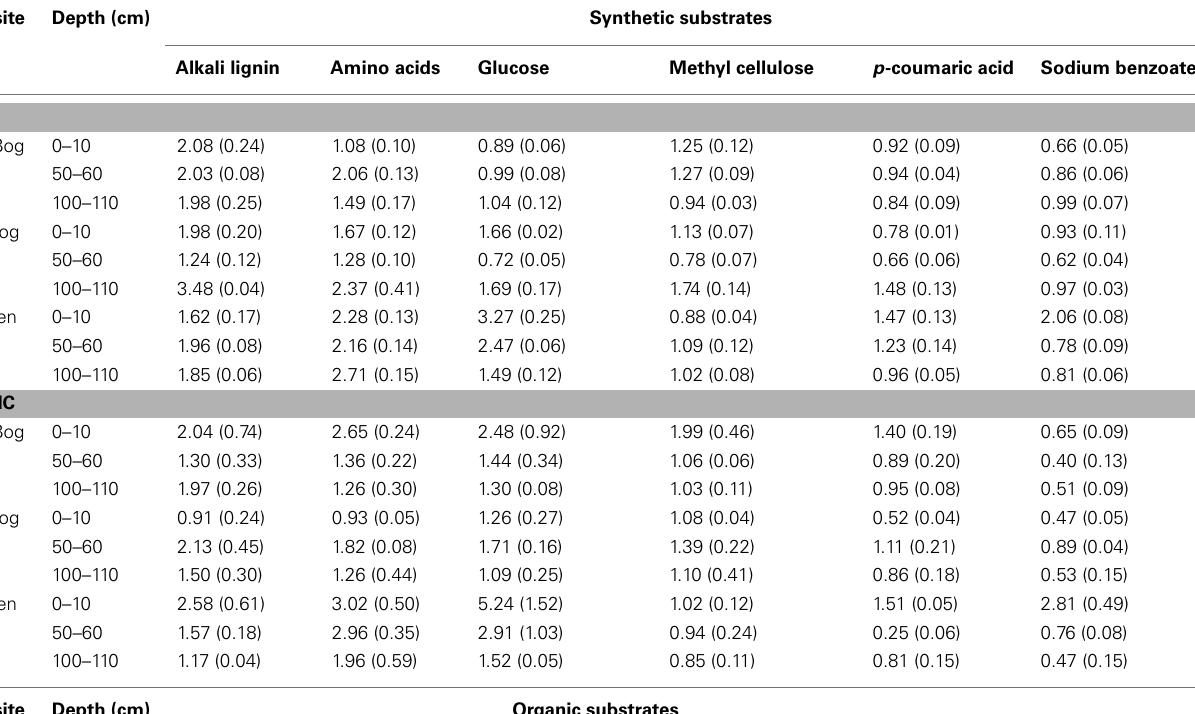
Table 2 | Substrate induced respiration ratios (substrate/basal respiration; mean ± 1SE) under oxic (16h) and anoxic conditions (48h) of peat soil at three depths from peat cores collected from the James Bay